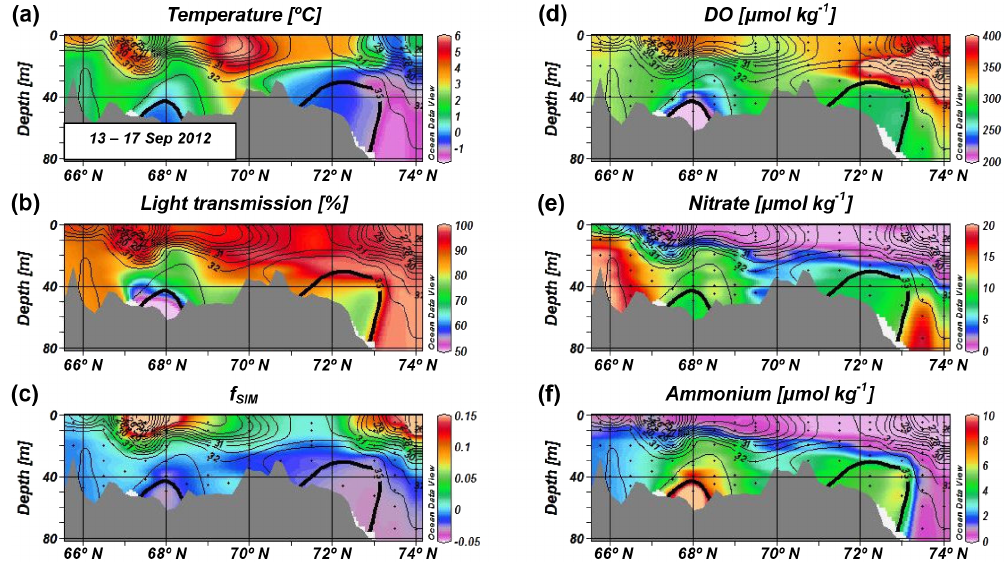
Figure 5. Vertical sections of (a) temperature ( ◦ C), (b) light transmission (%), (c) fraction of sea ice meltwater, (d) dissolved oxygen (µmolkg − 1 ) , (e) nitrate (µmolkg − 1 ) , and (f) ammonium (µmolkg − 1 ) along the 168 ◦ 45 (cid:48) W meridian near the US–Russia border obtained during the 13–17 September 2012 R/V Mirai cruise. The water sampling level at each station is indicated by a black dot. Salinity contours are superimposed on each section with a 0.5 contour interval. The thick contour in each section indicates a salinity of